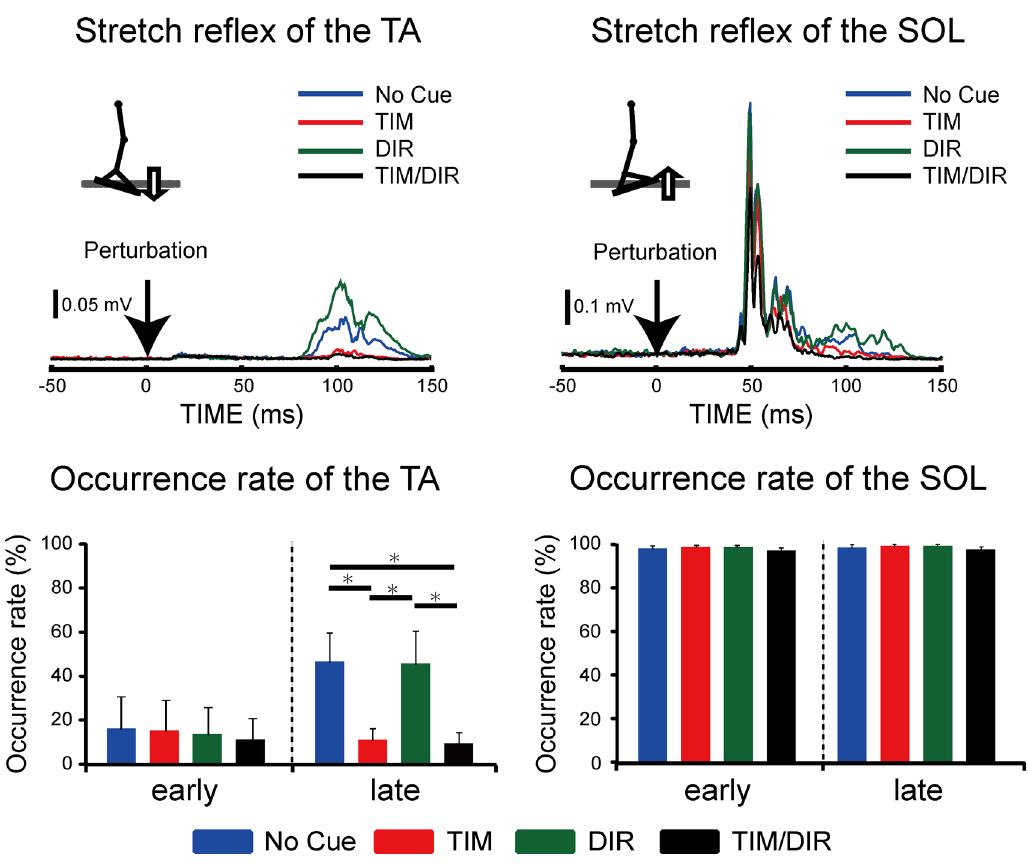
Fig 4. Representative ensemble-averaged waveforms of the stretch reflex responses in a single subject, and comparisons of the iEMG and occurrence rate of each reflex component in the TA and SOL among the different cue conditions in the supine position. The iEMG error bars indicate the SE of the mean value. The occurrence rate error bars indicate the SE of the mean value. * Statistically significant difference (p <